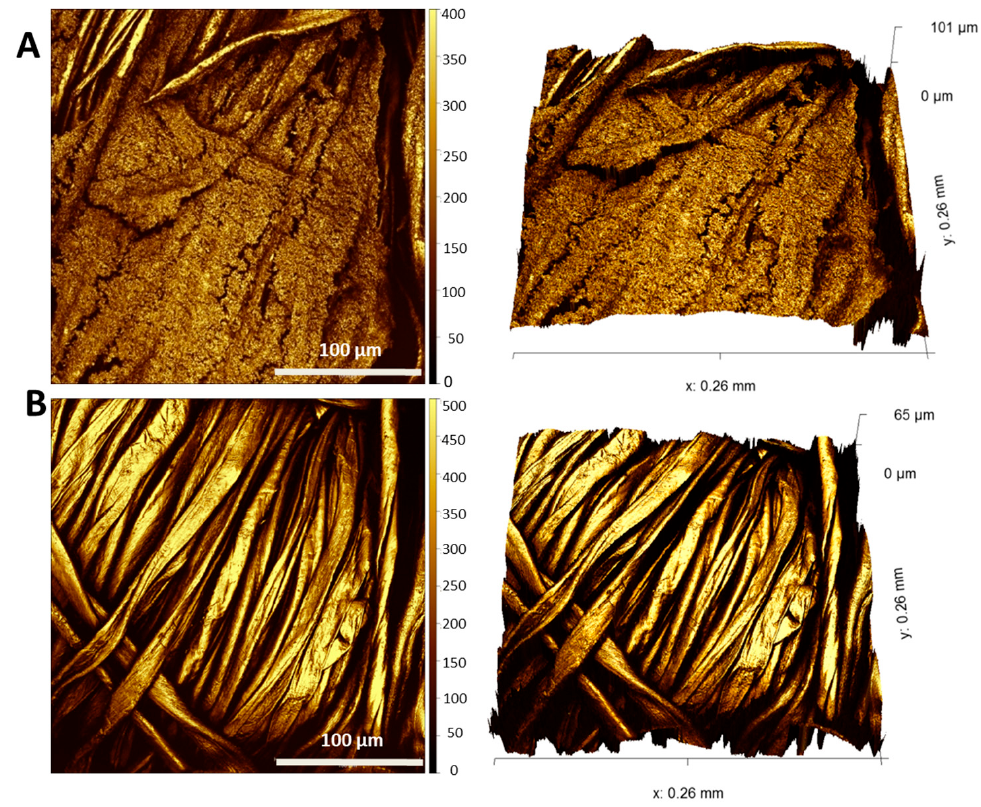
Figure 7. The 3D laser scanning microscopy images of P. aeruginosa grown for 48 h to form biofilms on cellulose substrates after 1 h of washing with F1/2 ( B ) in comparison to untreated controls ( A ). The pictures on the right side are tilted 3D illustrations.